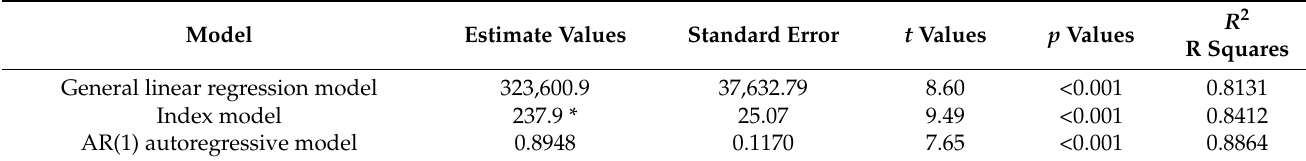
Table 3. Test results of three different models.